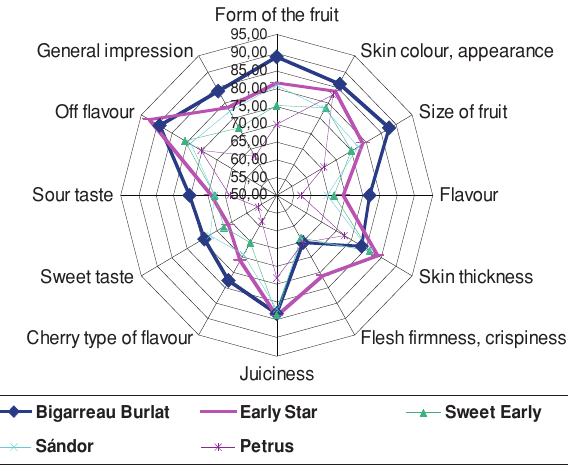
Figure 2. Profile diagram of the evaluation of early ripening sweet cherry varieties according to sensorial judgement